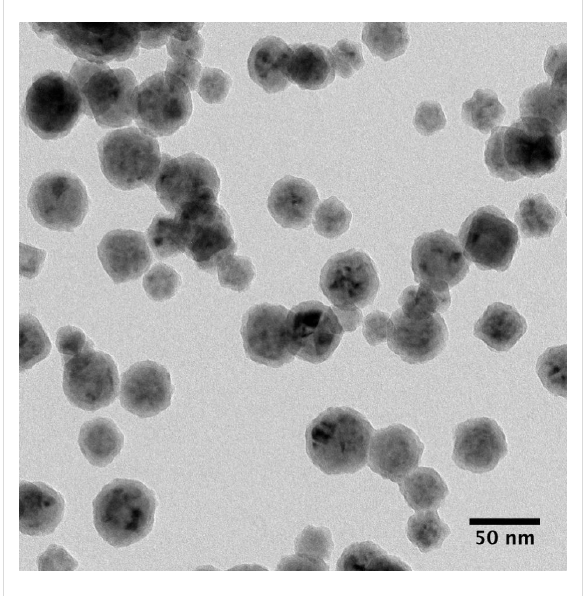
Figure 6: CS-NP deposited on a TEM grid coated with lacey carbon. The same bimodal size distribution as observed in SEM is retrieved.